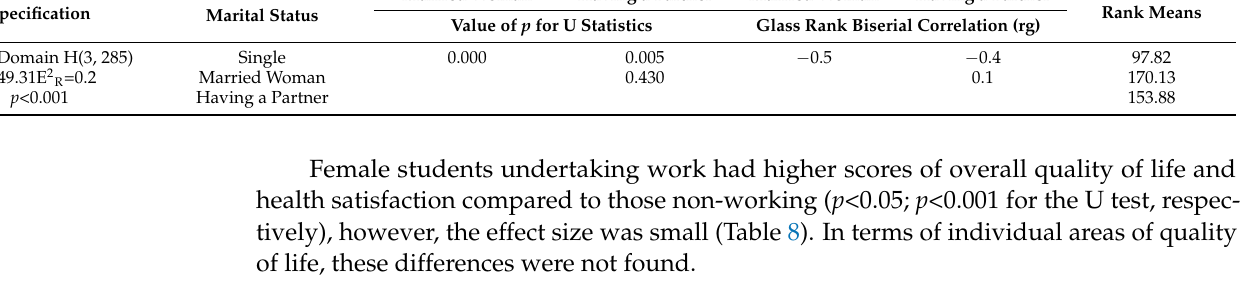
Table 7. Satisfaction with life, health, and particular domains of quality of life (WHOQOL-BREF) of female students by marital status (H test, E 2 R , U test, rg). Married Woman Having a Partner Married Woman Having a Partner Specification Marital Status Value of p for U Statistics Glass Rank Biserial Correlation (rg) Social Domain H(3, 285) = 49.31E 2 R =0.2 p <0.001